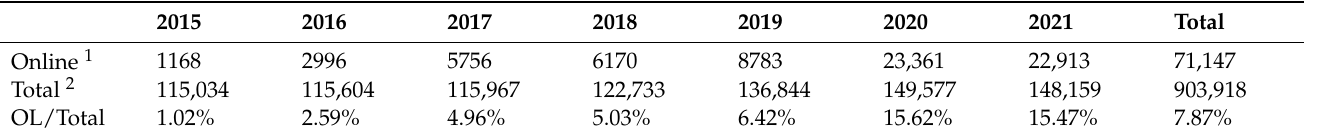
Table 4. Teaching hours of BL course in S